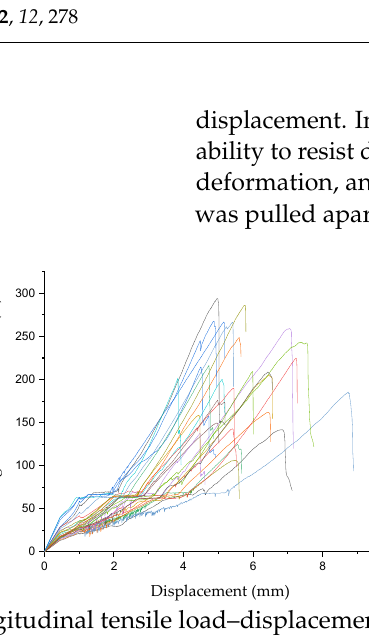
( b ) Characteristics of transverse tensile load–displacement curve. Figure 7. Transverse tensile test results of jujube bark: A is approximately the dividing point be- tween elastic stage and yield stage; B is approximately the dividing point between yield stage and strengthening stage; C is the point of tensile strength. The boxplot and data fitting line of the maximum tensile force test results of trans- verse tensile load–displacement were drawn (Figure 8). It can be seen from the boxplot (Figure 8a) that the IQR was small and there was no abnormal value, indicating that the data of each group of tests were relatively centralized. That is, the transverse tensile me- chanical properties of jujube bark were stable under the same natural state. According to the data fitting line of the maximum transverse tensile force shown in Figure 8b, the max- imum tensile load along the transverse direction of jujube bark was positively correlated with its corresponding trunk diameter. And the determination coefficient R 2 was 0.988, indicating that the fitted function had a high degree of fitting to the actual data. The fitting function is shown in Equation (9).